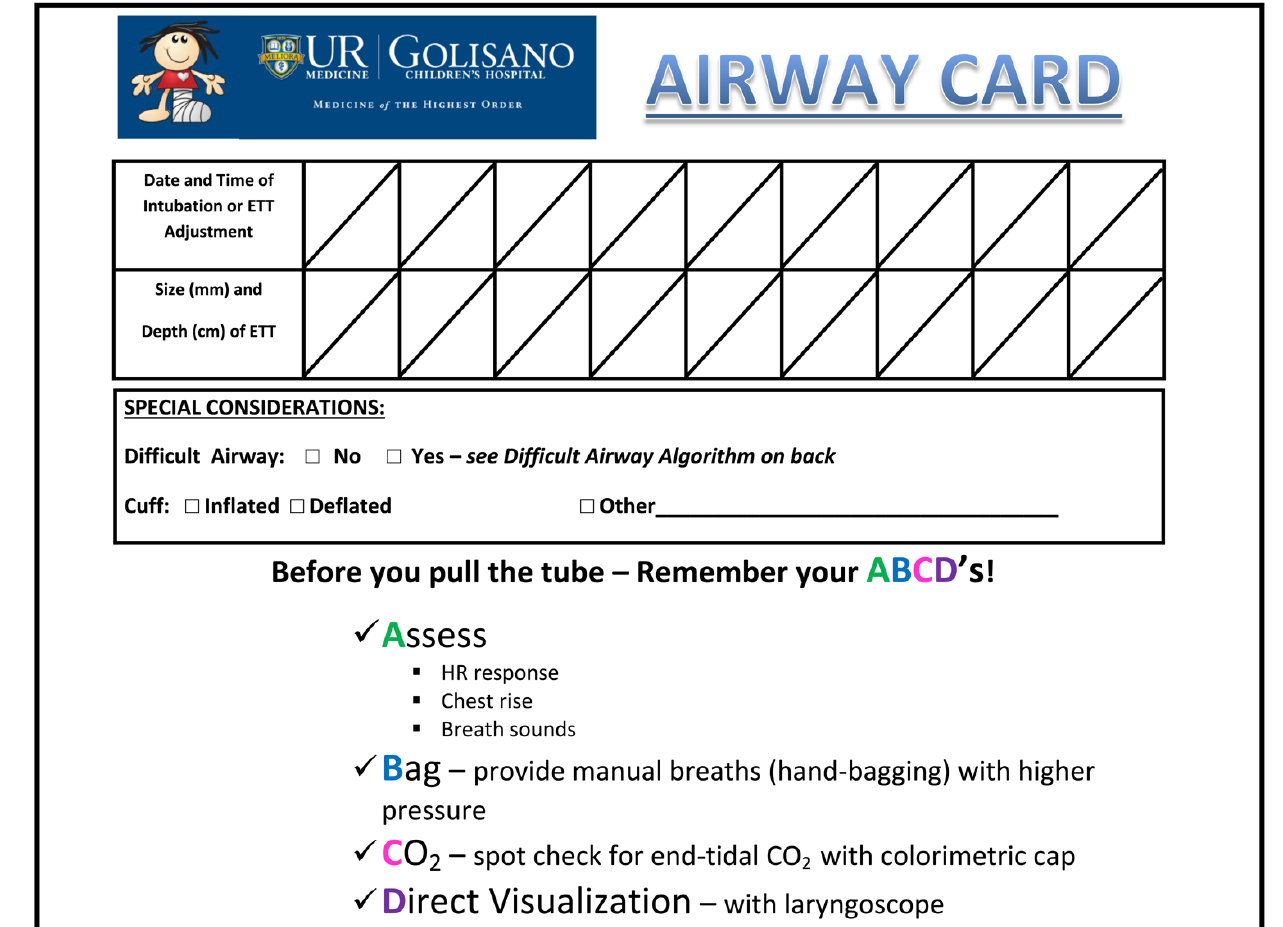
Figure 2. Example airway